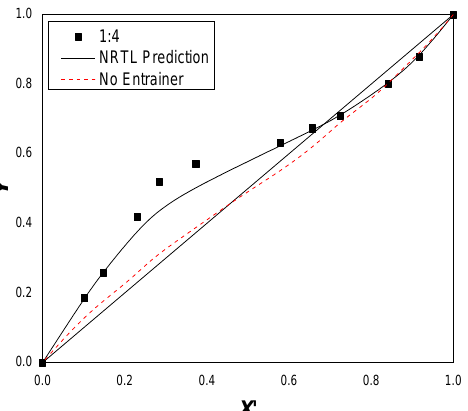
Figure 8. Experimental and calculated data X’Y diagram for cyclohexane (1) + benzene (2) + DES(1:4) (3) at constant pressure (101.325 kPa) and constant DES molar fraction ( X 3 = 0.1).